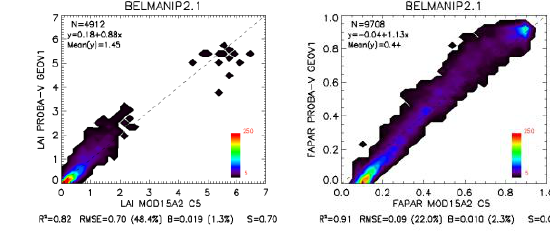
Figure 11: LAI and FAPAR PROBA-V GEOV1 versus MODIS C5 products scatter-plots over all BELMANIP-2.1 sites for the November 2103 - May 2014 period. The terms B and S represent the mean and the standard deviation of the